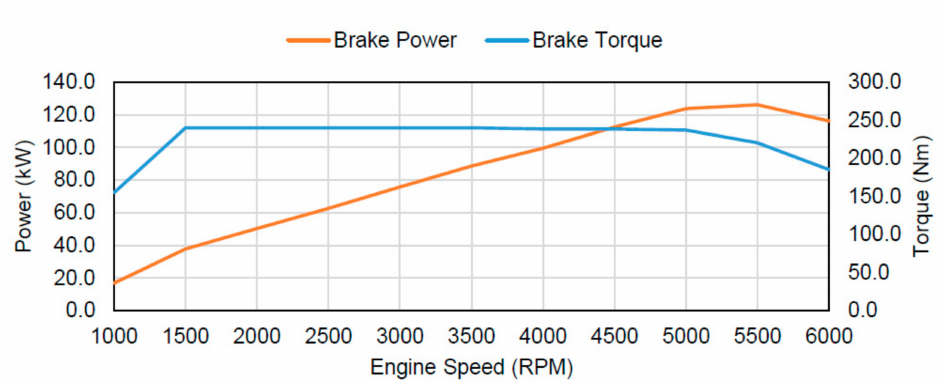
Figure 4. Torque and power performance of Ford Eco Boost 1.6 L petrol engine at full